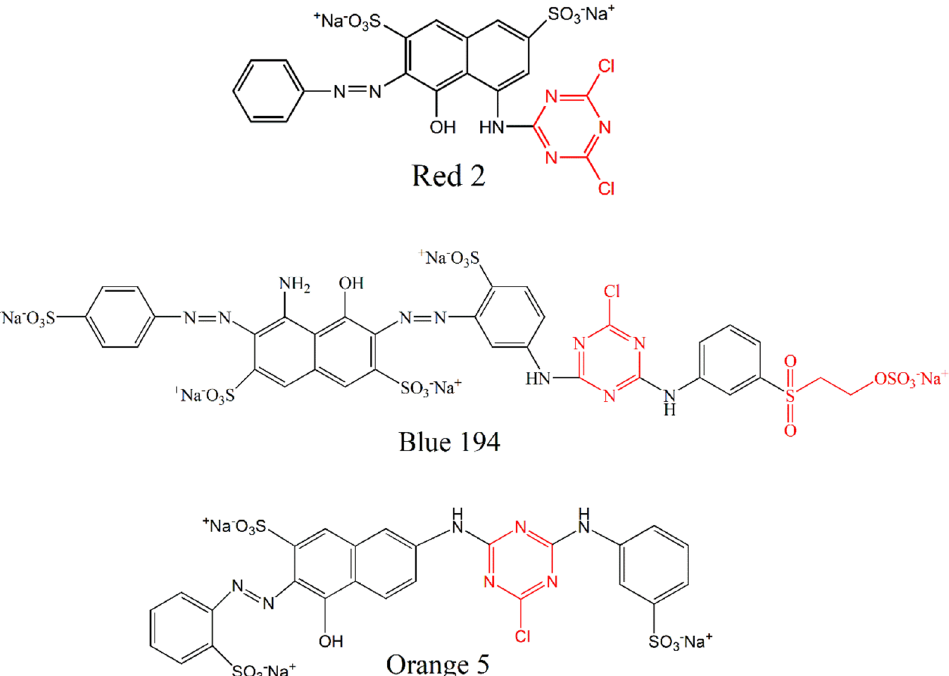
Figure 1. Molecular structures of the three dyes.